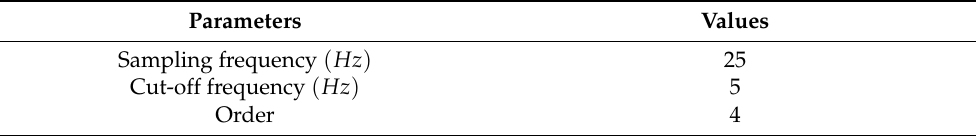
Table 2. Parameter settings of Butterworth filter.